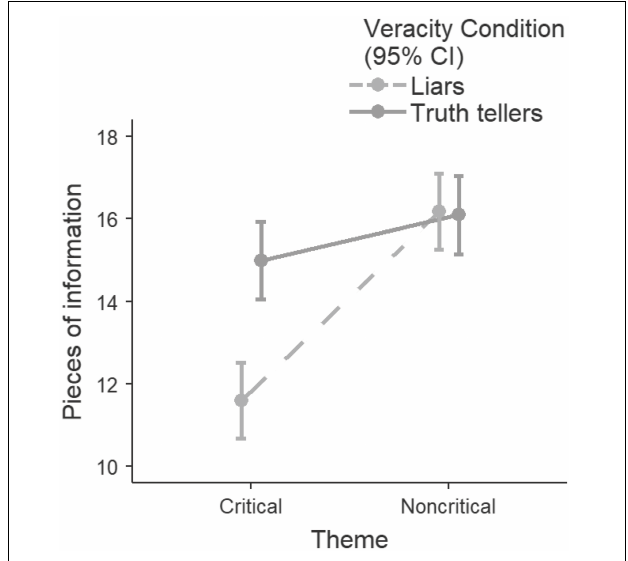
FIGURE 2 | Theme by Veracity interaction. Y-axis shows the amount of revealed information.